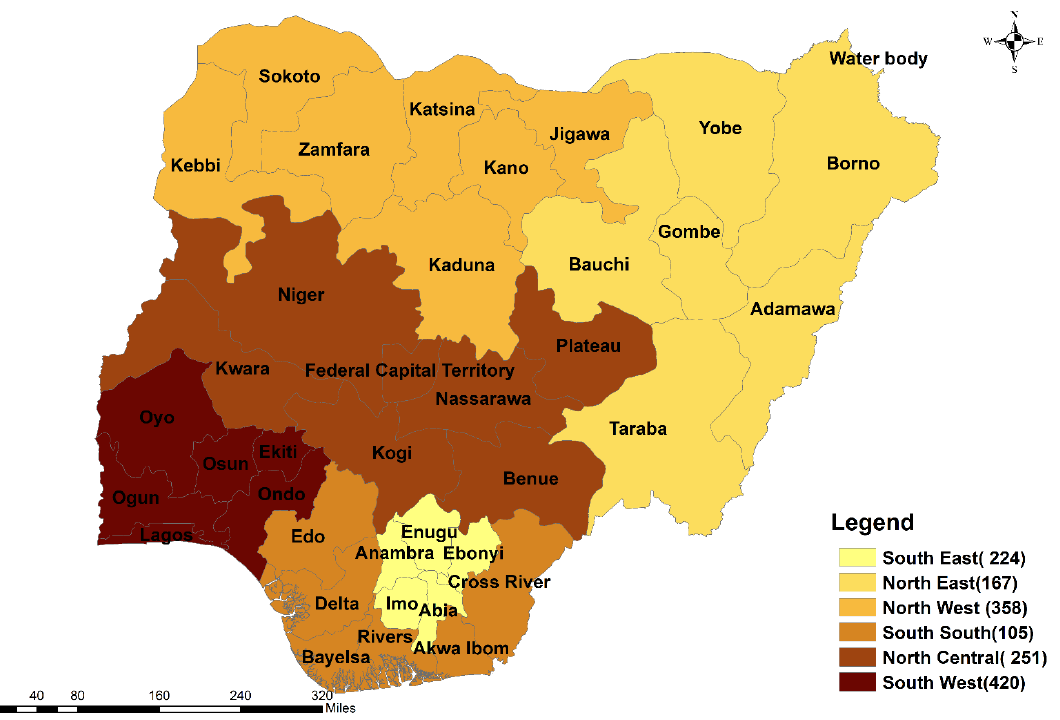
Figure 3. Distribution of the number of respondents across the six geopolitical zones of Nigeria.